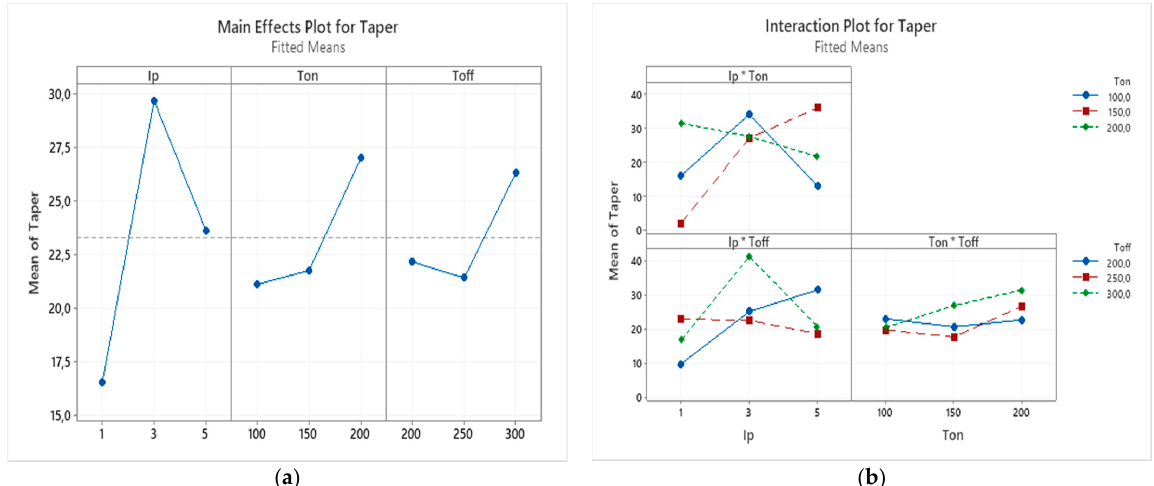
Figure 14. ( a ) The main effects and ( b ) the interaction effects plot for the taper.